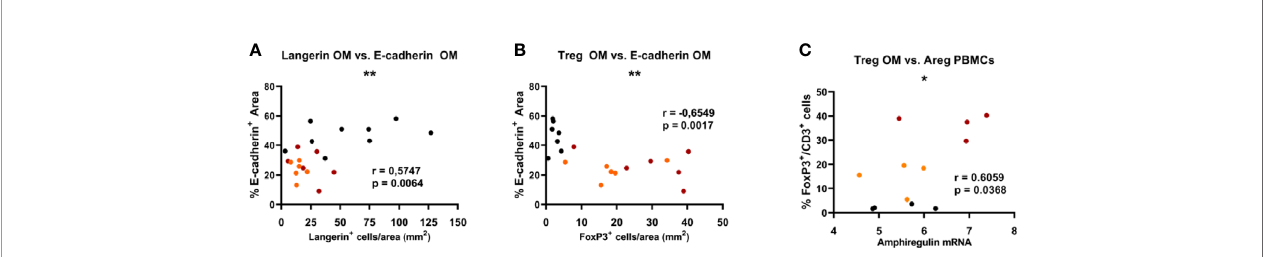
FIGURE 4 | Signi fi cant Spearman correlations found in the oral mucosa between the expression of epithelial E-cadherin and langerin (A) , and FoxP3 Treg frequency (B) . Signi fi cant correlations found in oral mucosa and PBMCs between the frequency of FoxP3 Treg cells in the oral mucosa and the expression of amphiregulin (Areg) (C) . Red dots represent de novo diagnosed patients, orange dots represent GFD, and black dots correspond to non-celiac (control) subjects. *p < 0.05, **p <